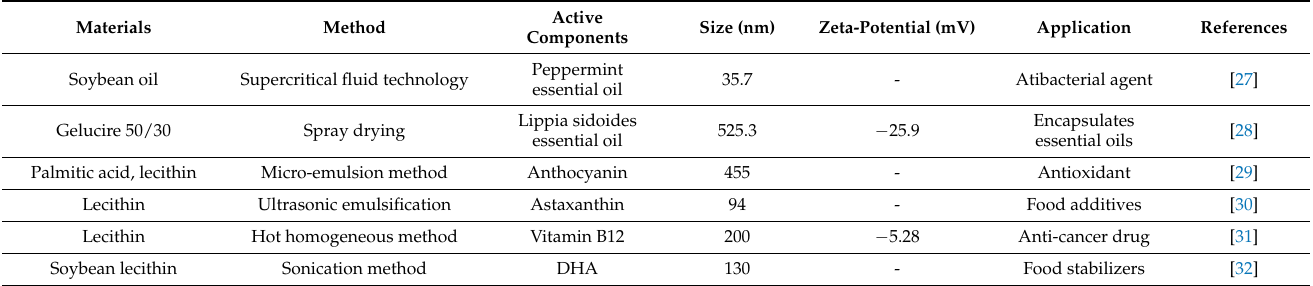
Figure 2. ( A ) The structure of nanoliposomes. ( B ) Schematic diagram of peppermint essential oil loaded hollow solid lipid micro- and nanoparticles. ( C ) TEM images of B12-loaded nanoliposomes. ( D ) Schematic illustration of DHA-loaded nanoliposomes. Table 1. Examples of nanoliposomes for functional food nanoparticle delivery